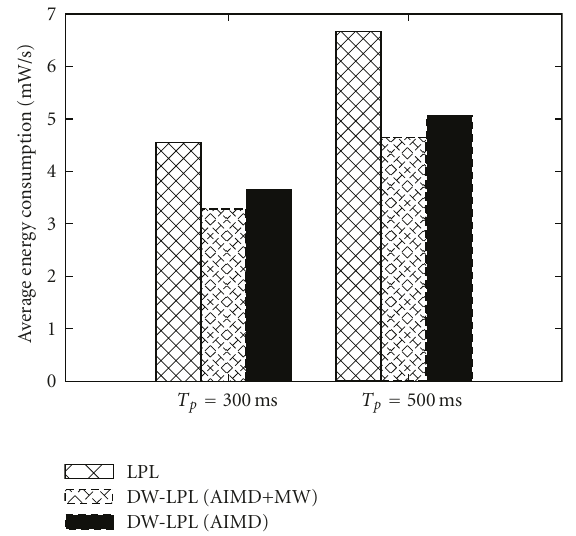
Figure 10: The experiment result on energy consumption in tree setup.